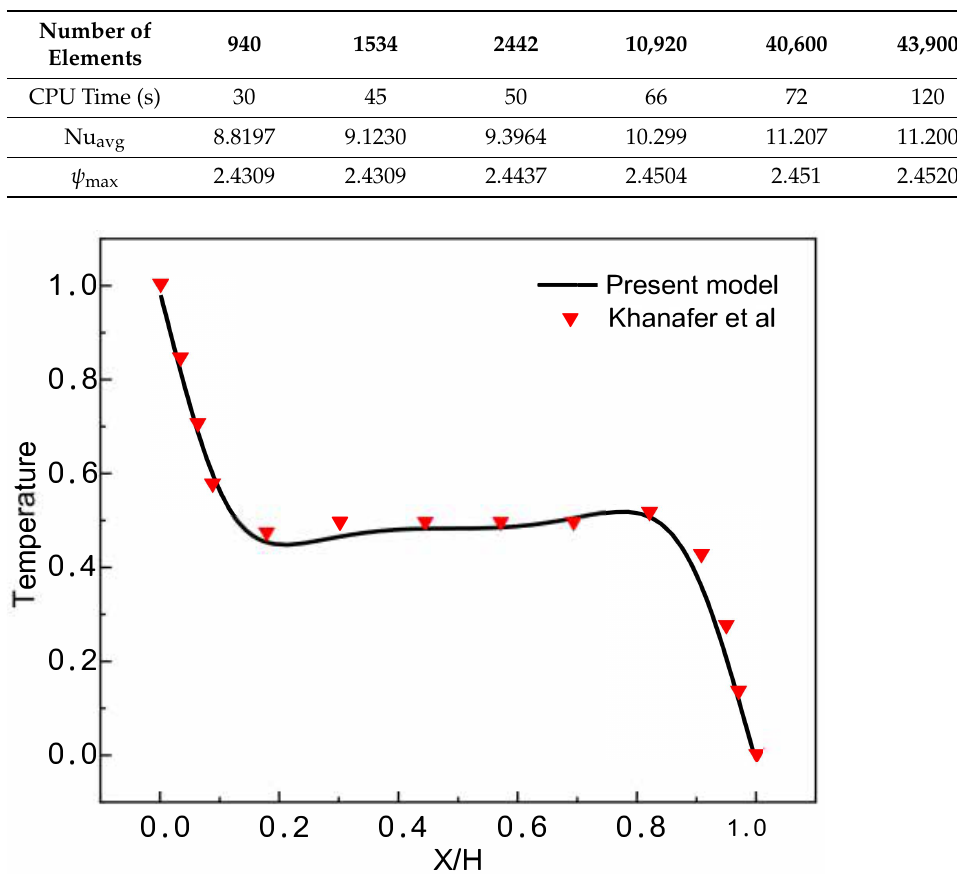
Table 2. Grid sensitivity check for the case 5 (Ha = 0, ϕ = 0.04, Da = 10 − 2 , and Ra = 10 5 ).